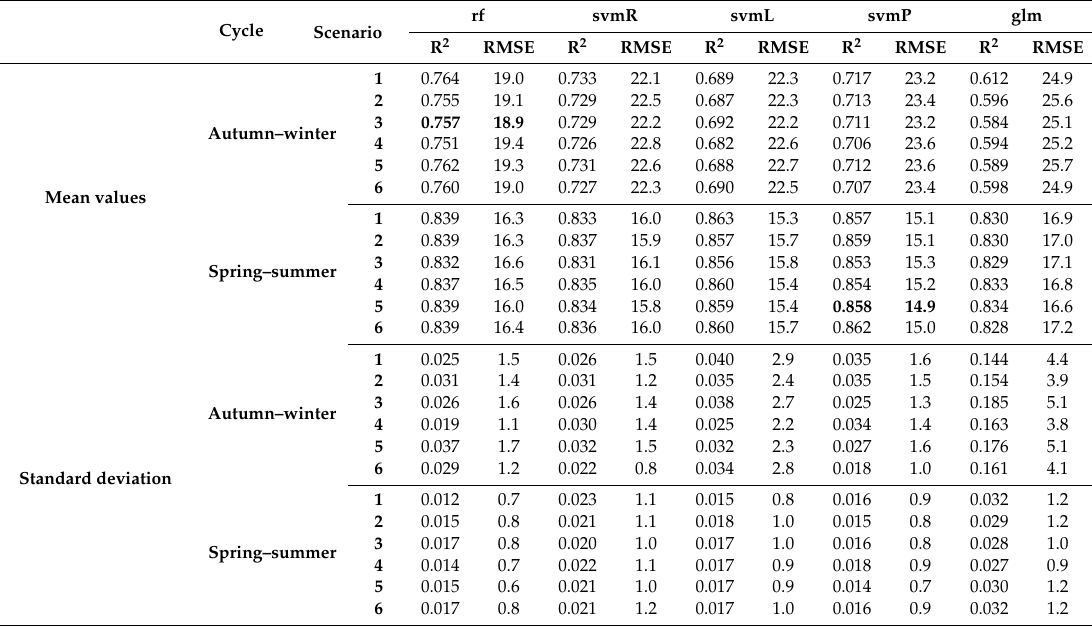
Table 3. Model performance of each algorithm, cycle, and scenario across 50 iterations, expressed as mean values of R 2 and %RMSE, and their corresponding standard deviations. The test dataset corresponds to the independent hold-out set (2017 and 2018).